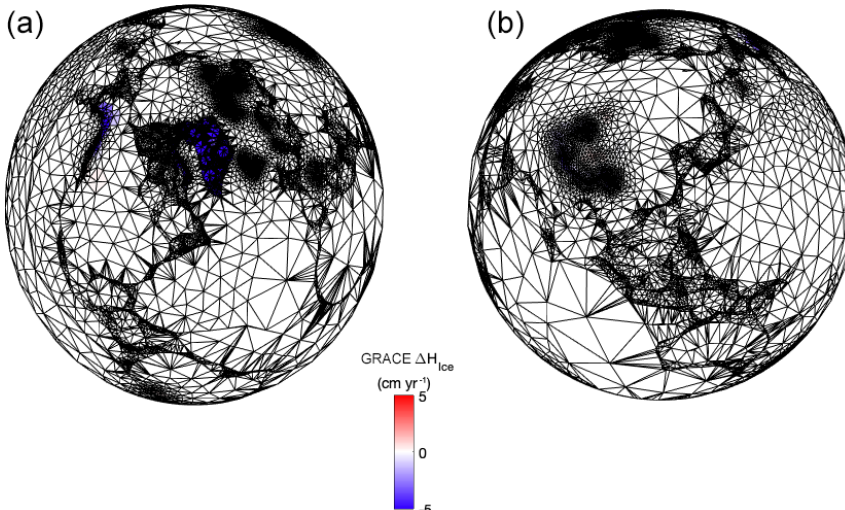
Figure 6. A 3-D Earth mesh stitched from 3-D projections of 2-D regional meshes of the following regions: South and North America, Australia, Eurasia and the Pacific, as well as Antarctica and Greenland. GRACE observations of ice mass change (in cmyr − 1 ) from 2003 to 2016 (Adhikari and Ivins, 2016) are laid over the mesh. The left frame azimuth is 30 ◦ with an elevation of 64 ◦ . The right frame azimuth is 205 ◦ with an elevation of 23 ◦ .